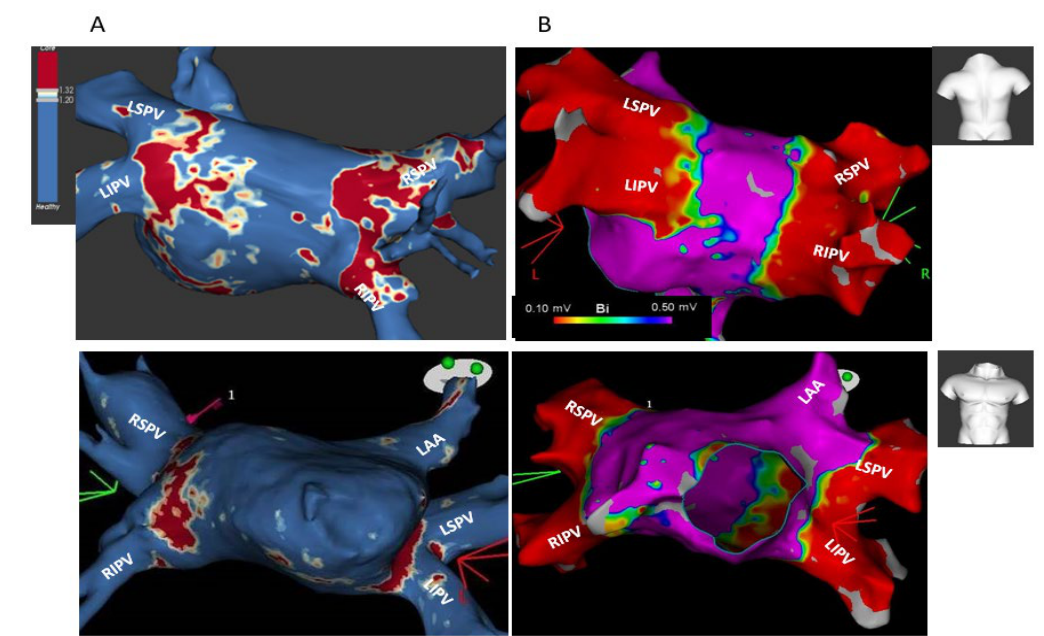
Figure 6. Correlation of post-index-ablation MRI to redo procedure electro-anatomic mapping (EAM): Circumferential PV ostial fibrosis around all PVs (upper-posterior views, lower-anterior views). Post-index-ablation MRI ( A ) shows a complete circumferential PV fibrosis around both left PVs and sub-complete circumferential fibrosis around both right PVs. Due to newly documented atypical AFL, the patient underwent redo ablation, which started with LA EAM (Carto system), revealing circumferential scars around all PV ostia ( B ). A good correlation found between post-index-ablation MRI and redo procedure EAM shown. Notably, Figures 2 and 6 both describe the same